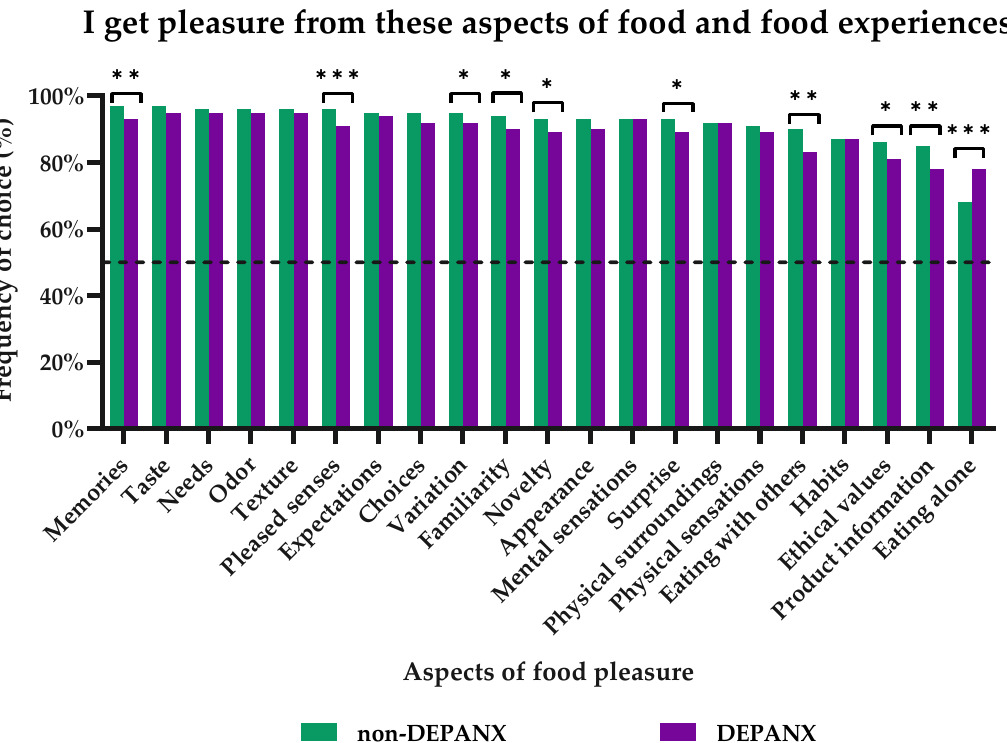
Figure 3. Subjective perception of pleasure from food and food experiences by the 21 different pleasure aspects of the Food Pleasure Scale. Results are shown for the two groups: ‘non-DEPANX’ ( n = 702) and ‘DEPANX’ ( n = 349). Stars indicate level of significance of p -values. *: p < 0.05, **: p < 0.01, ***: p < 0.001. Dotted line marks 50% frequency.